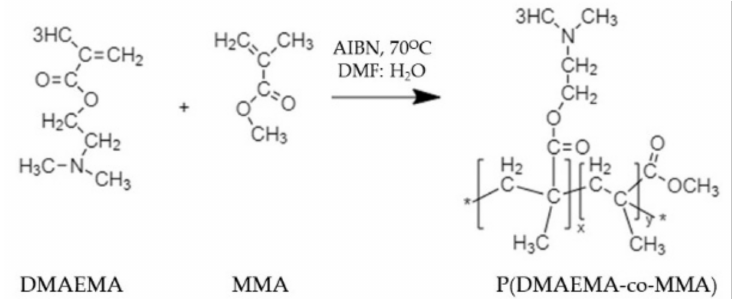
Figure 4. Synthesis of P(DMAEMA-co-MMA), an amphiphilic copolymer from hydrophilic DM- MAEMA monomer and hydrophobic MMA